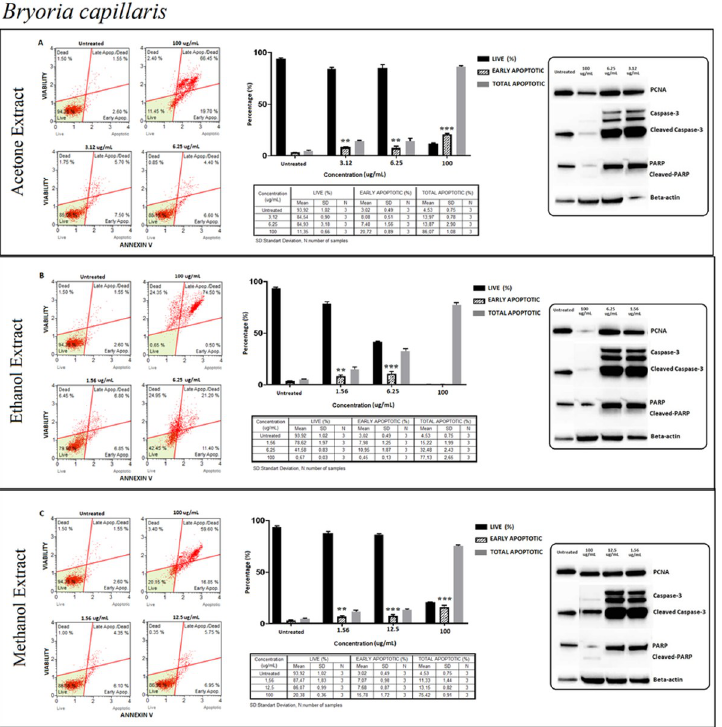
Fig 4. Bryoria capillaris (BC); Annexin V/7’AAD staining flow cytometry results (scatterplots), statistical analysis (bar graphs), ± SD values (tables) and protein expression levels of PCNA, caspase-3 and PARP by western blot (right panel) on PC-3 cells with acetone (A), ethanol (B) and methanol (C) extraction methods respectively. Basically, early apoptosis on PC3 cells is shown via Annexin V/7’AAD staining by flow cytometry. The gating was adjusted according to the untreated sample and the representative scatterplots were presented as the percentage of cells that were viable (Ann-V − and 7-AAD − ), early apoptotic (Ann-V + and 7-AAD − ), late apoptotic (Ann-V + and 7-AAD − ), and dead (Ann- V − and 7-AAD + ). Scatterplots are shown for untreated, 100 μ g/mL, 6.25 μ g/mL and 3.12 μ g/mL at 72 hours treatment with acetone extract (A) and for ethanol extract treatment, groups are untreated, 100 μ g/mL, 6.25 μ g/mL and 1.56 μ g/ mL at 72 hours treatment (B) and for methanol extract treatment, groups are untreated, 100 μ g/mL, 12.5 μ g/mL and 1.56 μ g/mL at 72 hours treatment (C) respectively. The 100 μ g/mL concentration is determined as toxic dose for all treatment groups. Results were analyzed and presented as the percentage of three independent experiments of live, early apoptotic and total apoptotic after treatment (bar graphs). Flow cytometry was shown to induce apoptotic cell death by mainly early apoptosis. The significance of only early apoptosis for each concentration indicated with an asterisk and the p value was only presented when the significance level of early apoptosis rate between 0.05 and 0.01. ± SD changes between apoptosis assays were indicated as the mean value and SD changes per concentration and per group of live-early apoptotic-total apoptotic separately (table). Western blot results of proliferating cell marker PCNA and apoptosis-related proteins (right panel) were presented. Dose-dependent PCNA, cleavage of caspase-3 and, PARP respectively. Apoptosis rate seems increased significantly by treatment with specified concentrations by flow cytometry however western blot data showed otherwise, particularly for cleaved-PARP. In addition, the proliferation (PCNA) status remained stable. � p < 0 . 05 , �� p < 0 . 001 , ��� p < 0 . 0001 (all p-values were obtained by two-way ANOVA following Dunnet’s multiple comparison